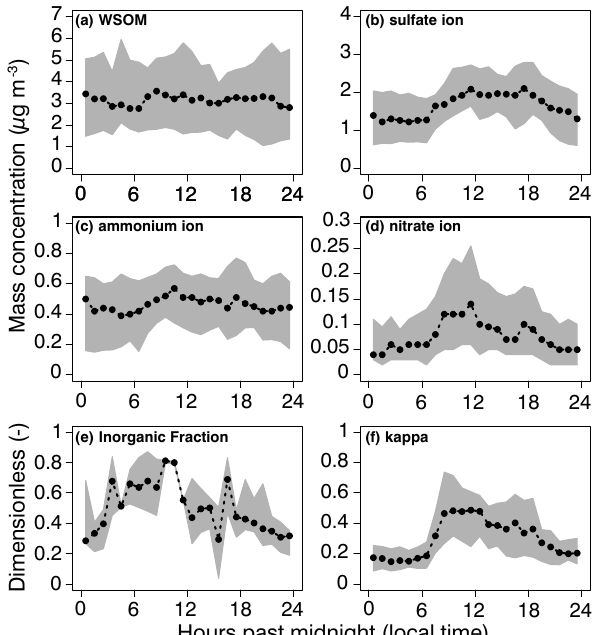
Figure 10. Diurnal trend of select aerosol chemical species meas- ured by PILS-IC and WSOM calculated from PILS-WSOC. The central black line shows the median of the measurements. The shaded area indicates the interquartile range. Panel (e) shows the ratio of P (b) + (c) + (d) over P (a) + (b) + (c) + (d) . Panel (f) is identical to Fig. 8.